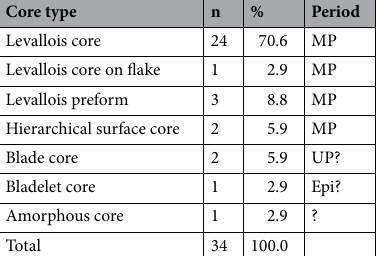
Table 3. Typology of cores in the Rockefeller Museum Shukbah Layer D